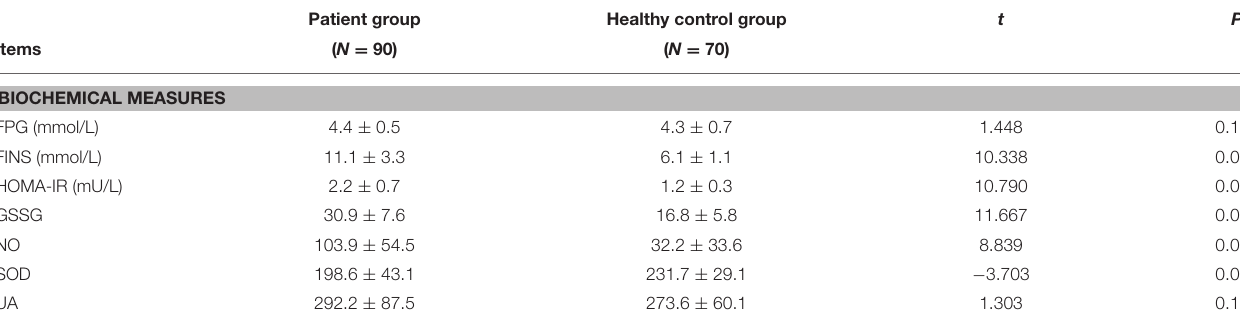
TABLE 2 | Comparison of insulin resistance and oxidative stress measures between the two groups. Patient group Healthy control